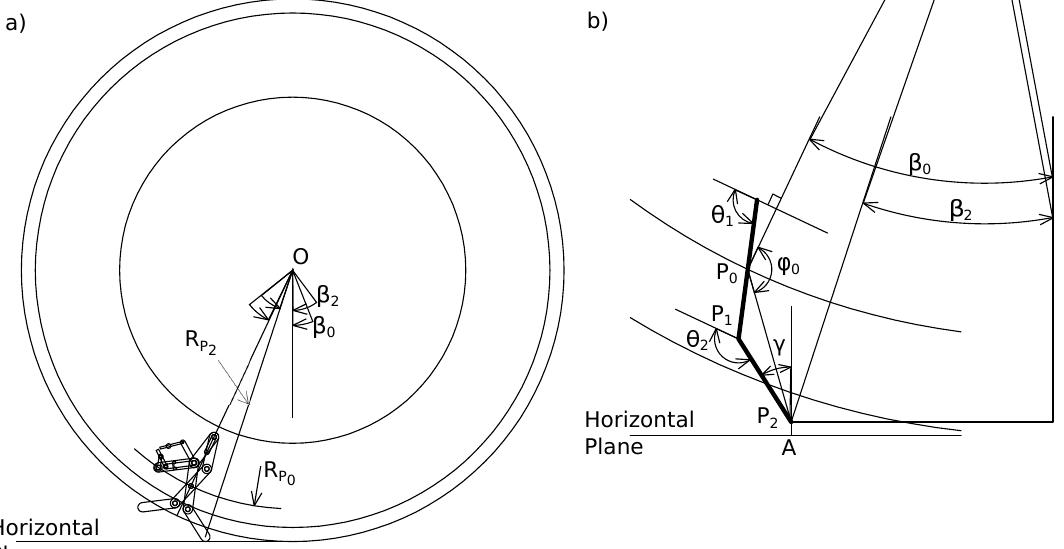
Figure 5. ( a ) View showing situation when link 2 touches the plane; ( b ) detailed